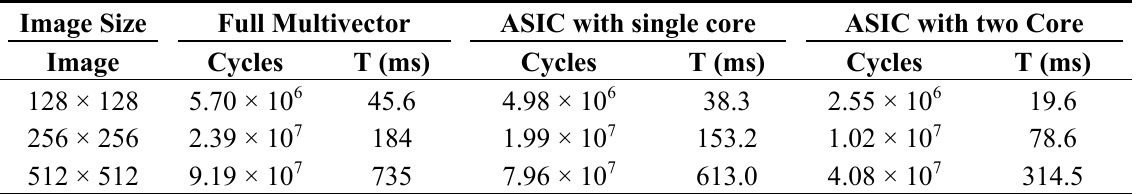
Table 5. Four GP for rotor convolution.